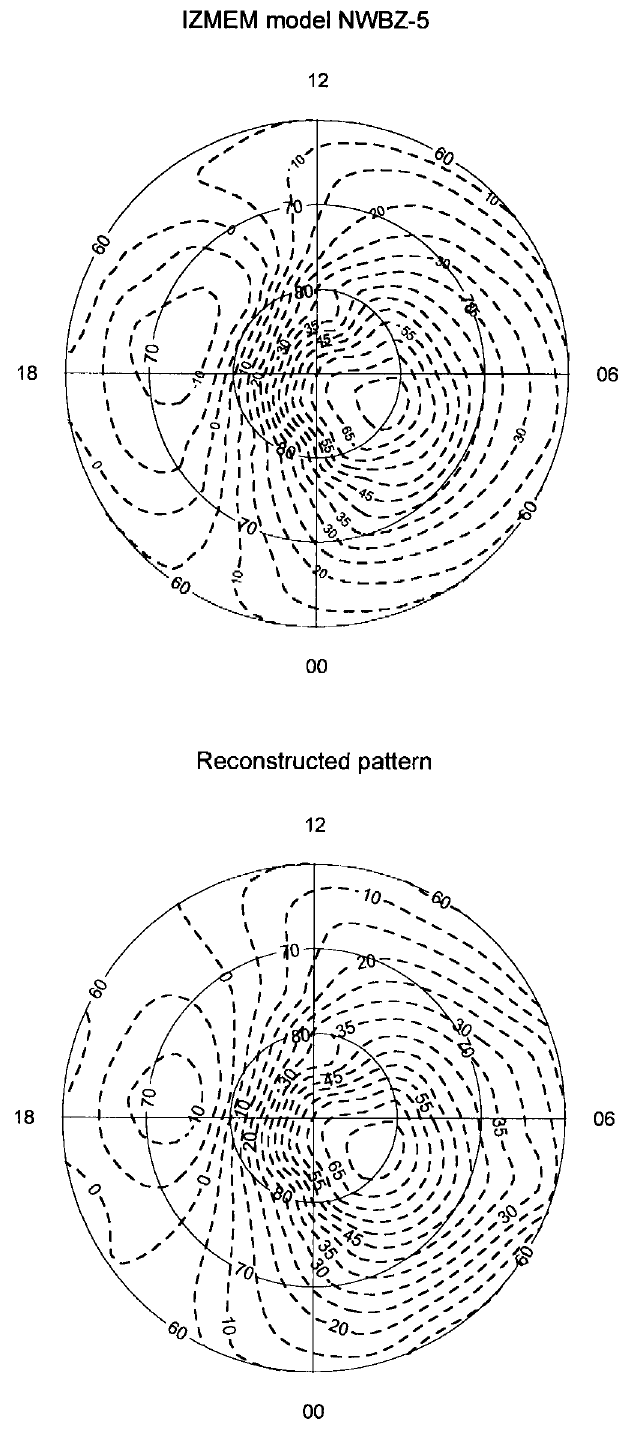
Fig. 1. Top distribution of the electric potentials in the northern winter polar cap for southward IMF ( B x (cid:136) 0, B y (cid:136) 0, B z (cid:136) (cid:255) 5 nT) obtained from the IZMEM/DMSP model. Bottom distribution of the electric potentials reconstructed by the electric field data along the noon-midnight and dawn–dusk MLT meridians using the stream